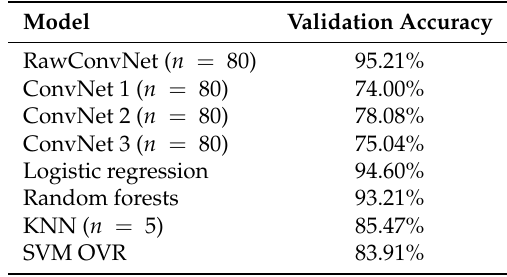
Table 13. Performance summary for DL and ML models on BUZZ1 validation